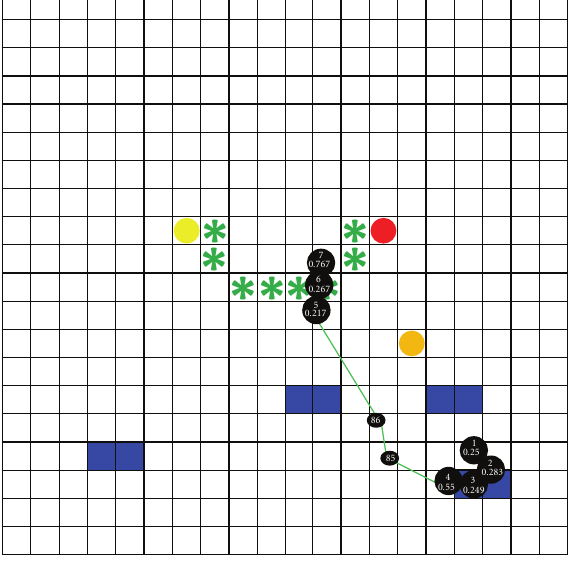
Figure 10: Last part of an eye-gaze path, reduced to fixations and superimposed on the task image.